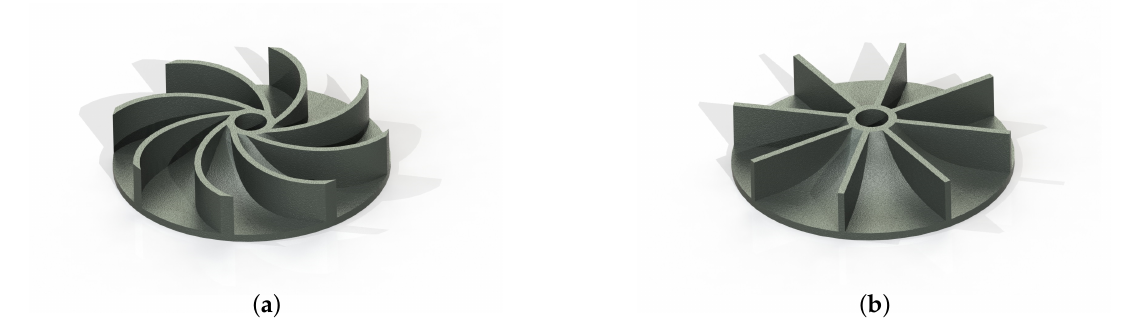
Figure 5. Schematic view of impellers ( a ) with curved blades; and ( b ) with straight blades.